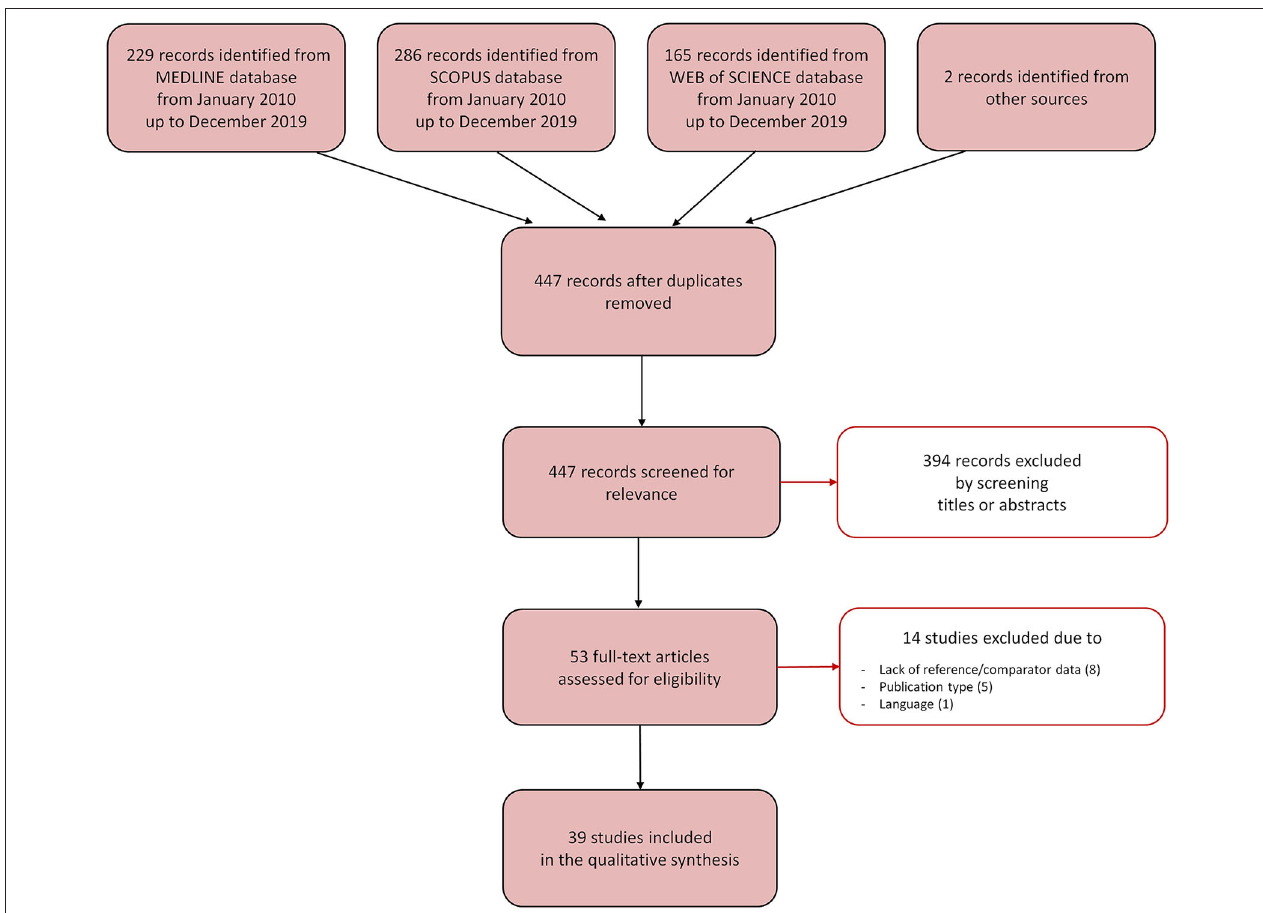
FIGURE 3 | Selection process for the studies included in the scoping review. The Preferred Reporting Items for Systemic Reviews and Meta-Analyses [PRISMA-sc ( Tricco et al., 2018)] flow diagram depicts the number of records identified, included and excluded, and the reasons for exclusion, through the different phases of the scoping